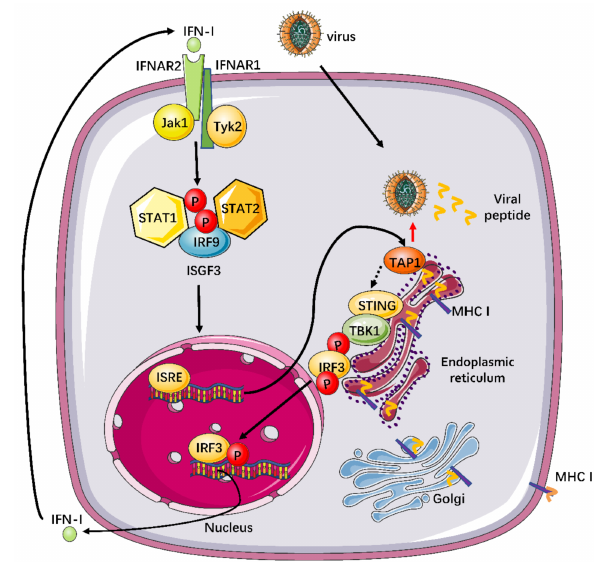
Figure 5. Working model to illustrate the TAP1-involved innate signal pathway against broadly viral infections. TAP1 plays a critical factor in the profound virus-host interactions, especially in innate and adaptive immunity. TAP1 can regulate adaptive immunity through promoting the major histocompatibility complex (MHC) class I-mediated antigen presentation. Additionally, our study also demonstrated that TAP1 could promote type I interferon production through activating the TBK1-IRF3 signal pathway. Subsequently, Type I IFNs can bind to IFNAR2, then recruit IFNAR1, and consequently, form a signaling-competent ternary complex to activate the transcription factor IRF9 and ISGF3 complex, which is comprised of phosphorylated STAT1 and STAT2, through the JAK-STAT signal pathway. The activated ISGF3 can translocate to the nucleus and bind to IFN-stimulated response elements (ISREs) in the upstream promoter regions of ISGs, which can encode the numerous proteins with potent antiviral